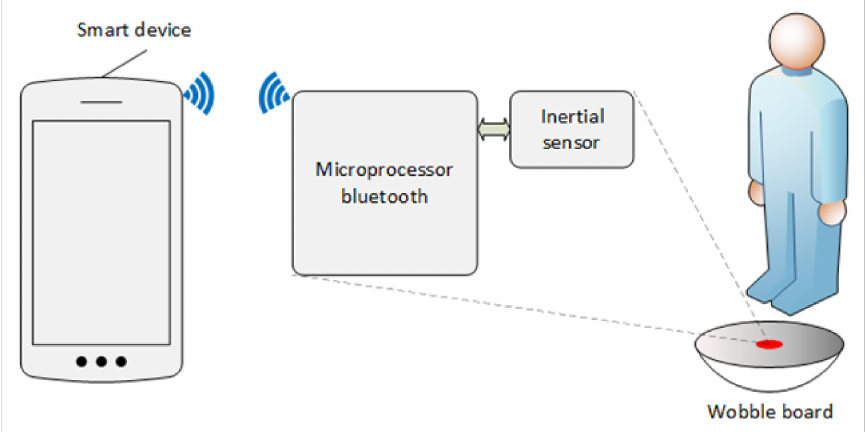
Figure 1. Experimental wobble board